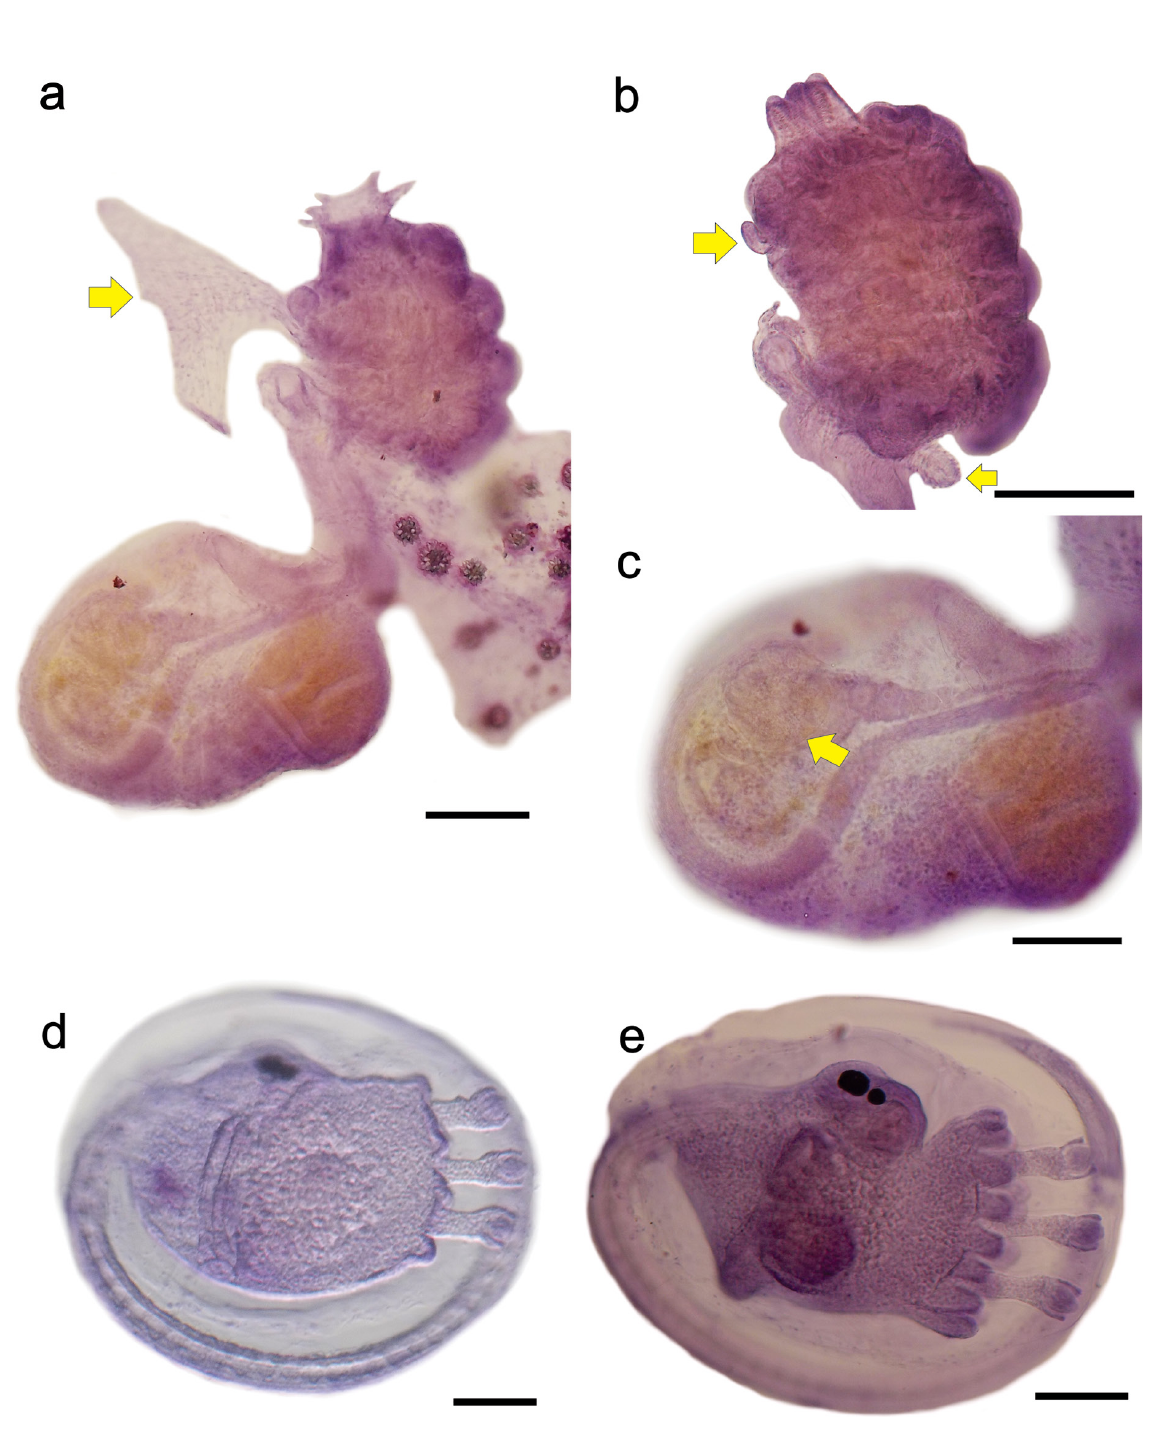
Fig. 10. Polysyncraton purou C. Monniot & F. Monniot, 1987, with structures stained with hemalum (MNHN A2-843). a . Zooid with bifurcated atrial languet (arrow). b . Thorax with button-like atrial languet (big arrow) and muscular process (small arrow). c . Abdomen with gonads (large arrow indicates oocyte). d . Immature larva. e . Mature larva. Scale bar: 0.1